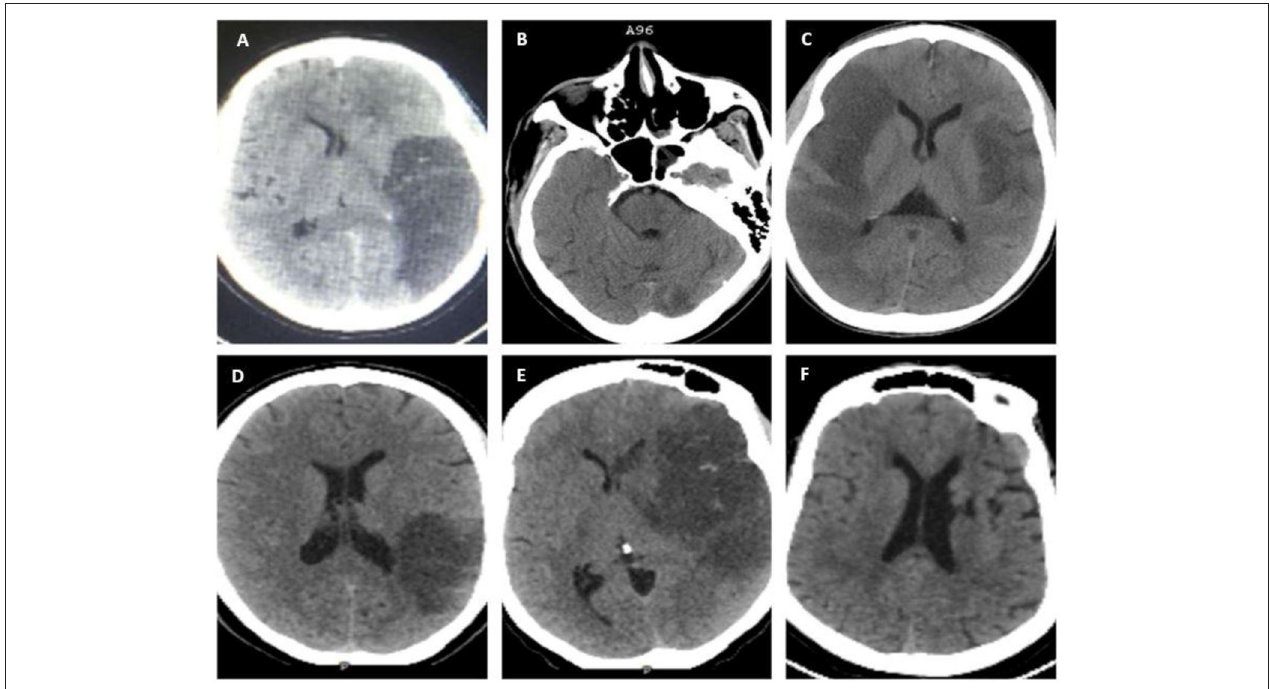
FIGURE 1 | Non-contrast brain computed tomography (NCCT) scans showing evidence of ischemic infarcts in various vascular territories; (A) left distal middle cerebral artery (MCA) M1 with HI 1; (B) basilar and left posterior cerebral artery (PCA) infarction with a hyperdense basilar sign; (C) bilateral MCA: right M1 and left distal M1/ proximal M2; (D) inferior division M2 MCA with HI 1; (E) left proximal M1 with HI 1; and (F) left Lacunar infarct